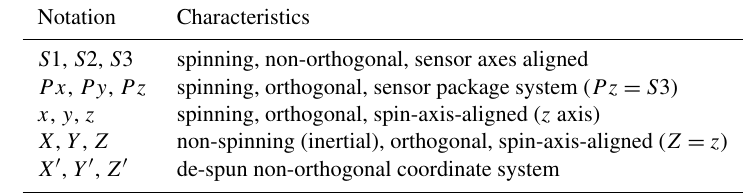
Table 1. List of coordinate system notations used in this paper similar to Table 1 in Kepko et al. (1996).